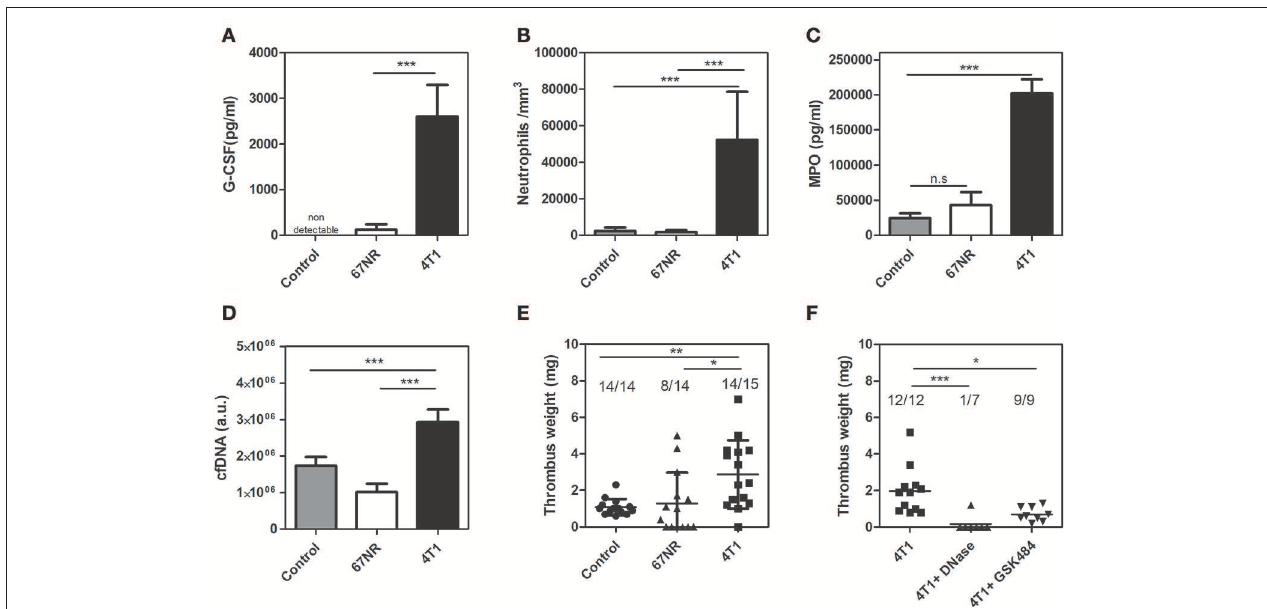
FIGURE 2 | 4T1 tumor-bearing mice but not 67NR tumor-bearing mice exhibit neutrophilia and a NET-dependent prothrombotic state. (A) Systemic levels of G-CSF in control (gray bars, n = 5), 67NR (open bars, n = 3) and 4T1 (black bars, n = 5) tumor-bearing mice were assessed by a specific ELISA kit as described in section Materials and Methods. (B) Neutrophil counts in control (gray bars, n = 12), 67NR (open bars, n = 5) and 4T1 (black bars, n = 11) tumor-bearing mice were evaluated as described in section Materials and Methods. Two systemic markers of NETs, MPO (C) and cfDNA (D) , were analyzed in control (gray bars, n = 5), 67NR (open bars, n = 3) and 4T1 (black bars, n = 6) tumor-bearing mice as described in section Materials and Methods. For systemic analysis, the blood was collected 21 days after the tumor cell inoculation. (E) Venous thrombosis was evaluated with stasis of the inferior vena cava for 6h in control (•, n = 14), 67NR ( N , n = 14), and 4T1 ( (cid:4) , n = 15) tumor-bearing mice. (F) Alternatively, 4T1 tumor-bearing mice ( (cid:4) , n = 12) were treated with DNase I (50 µ g, i.v.) ( N , n = 7) or GSK484 (10 mg/kg, i.v.) ( H , n = 9) just before performing the procedure to induce stasis of the inferior vena cava for 3h. Each dot represents one individual mouse. Values represent the mean ± SD. * P < 0.05, ** P = 0.01, and *** P = 0.001; n.s., non-significant, analysis of variance (ANOVA) followed by Tukey’s post-hoc